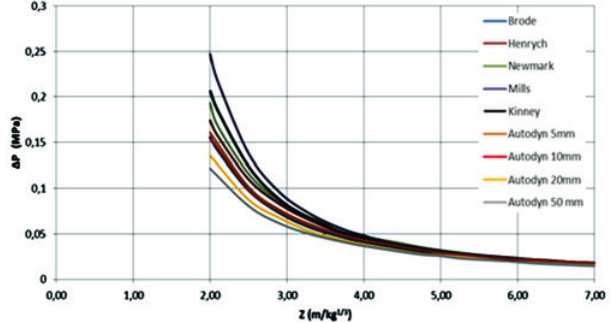
Figure 7 Comparison between the prediction methods and the numerical results of shock wave overpressures